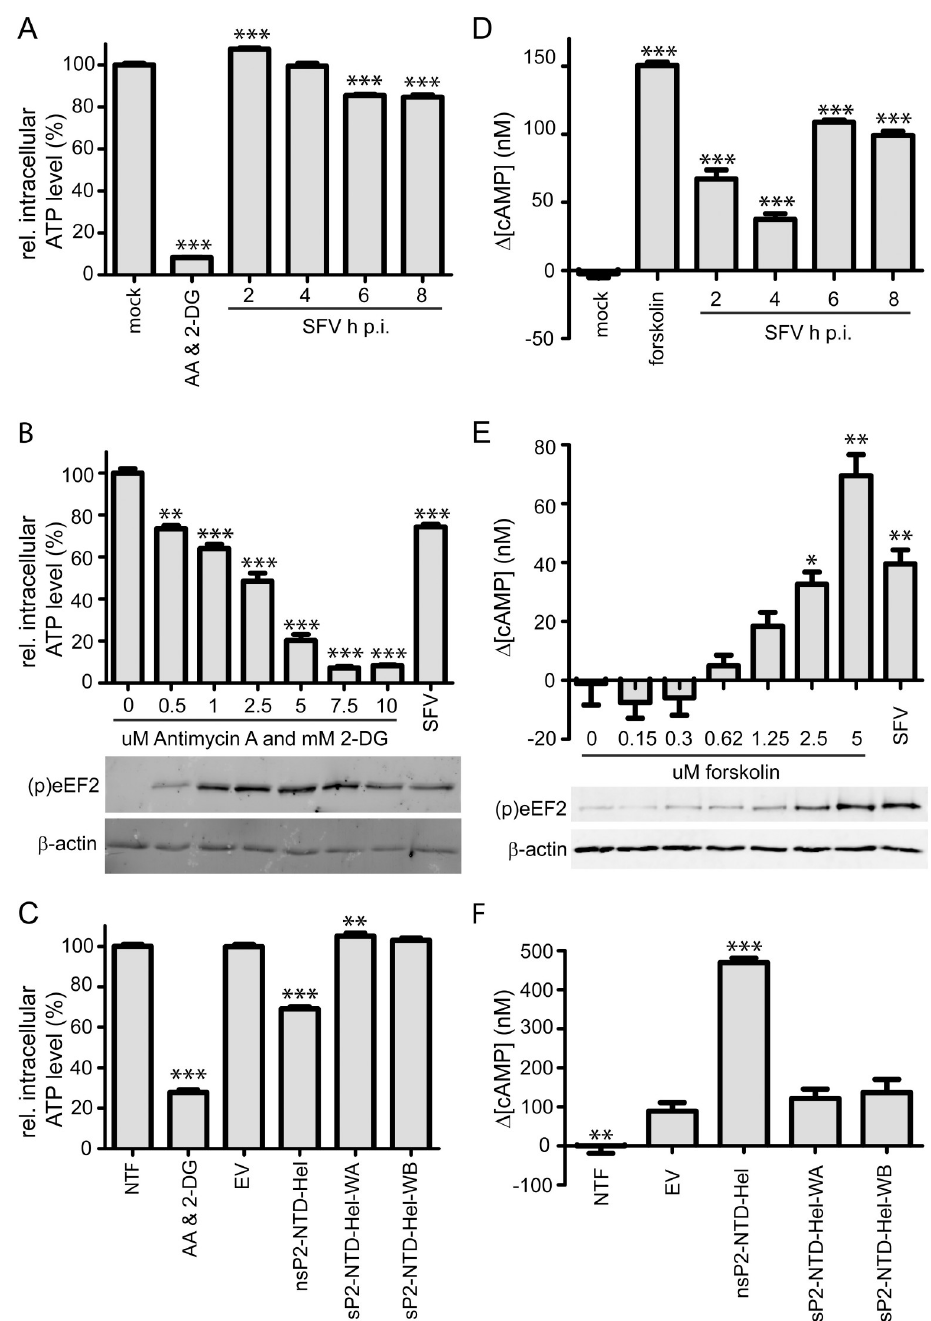
Fig 7. Changes in cellular ATP and cAMP levels are associated with CHIKV nsP2 induced eEF2 phosphorylation. For panels A, B and C the CellTiter-Glo 2.0 assay was used to determine relative cellular ATP levels and for panels D, E and F the cAMP-Glo assay was used to determine changes in cellular cAMP concentrations. ( A ) Vero E6 cells were infected with SFV (MOI 10) and at 2, 4, 6 and 8 h p.i. cellular ATP levels were determined relative to the level in mock- infected cells at 8 h p.i. A combination of ATP-depleting compounds antimycin A (AA) (10 μ M) and 2-DG (10 mM) was used as a control. Bars represent the averages of two independent experiments with 8 replicates each. ( B ) Vero E6 cells were incubated for 30 min with increasing concentrations of antimycin A and 2-DG. (p)eEF2 (T56) was detected by WB. Cells infected with SFV (MOI 10) at 6 h p.i. were included as a positive control. Bars represent the averages of two independent experiments with two or three replicates each. P-value �� < 0.01, ��� < 0.0001 compared to no compounds added ( C ) 293T cells were transfected with the pCAGGS-IRES-GFP construct containing